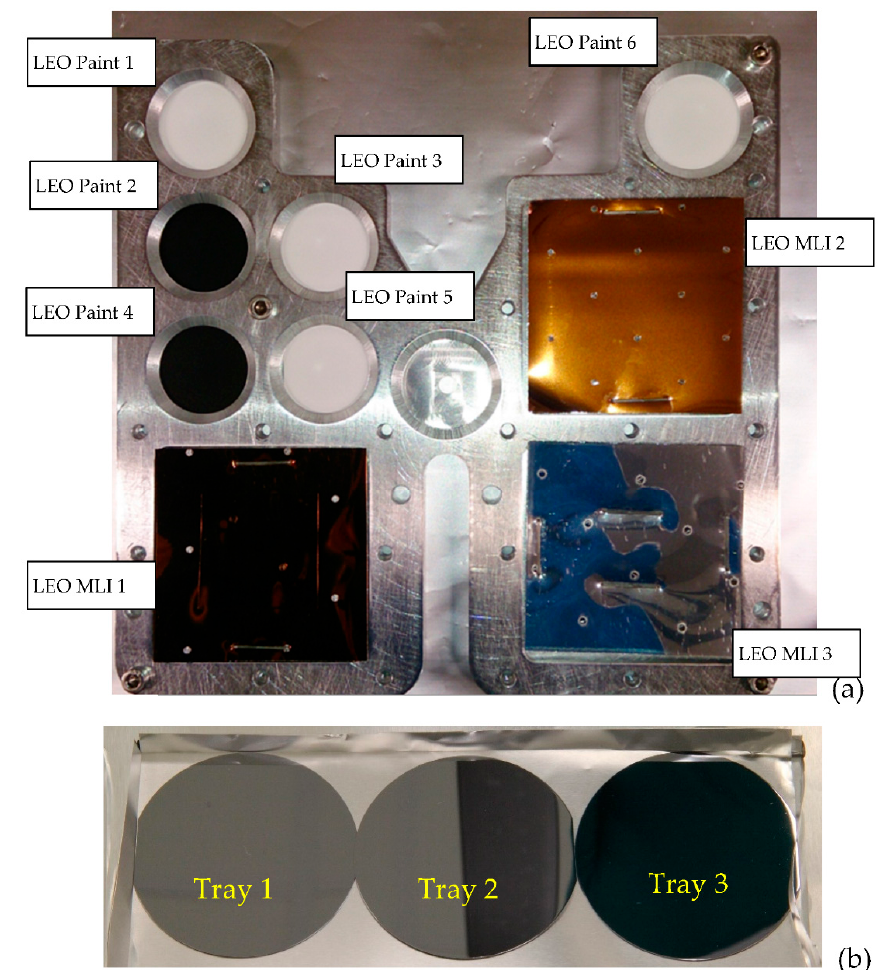
Figure 20. ( a ) ATOX (atomic oxygen) sample holder. ( b ) Silicon sample trays.